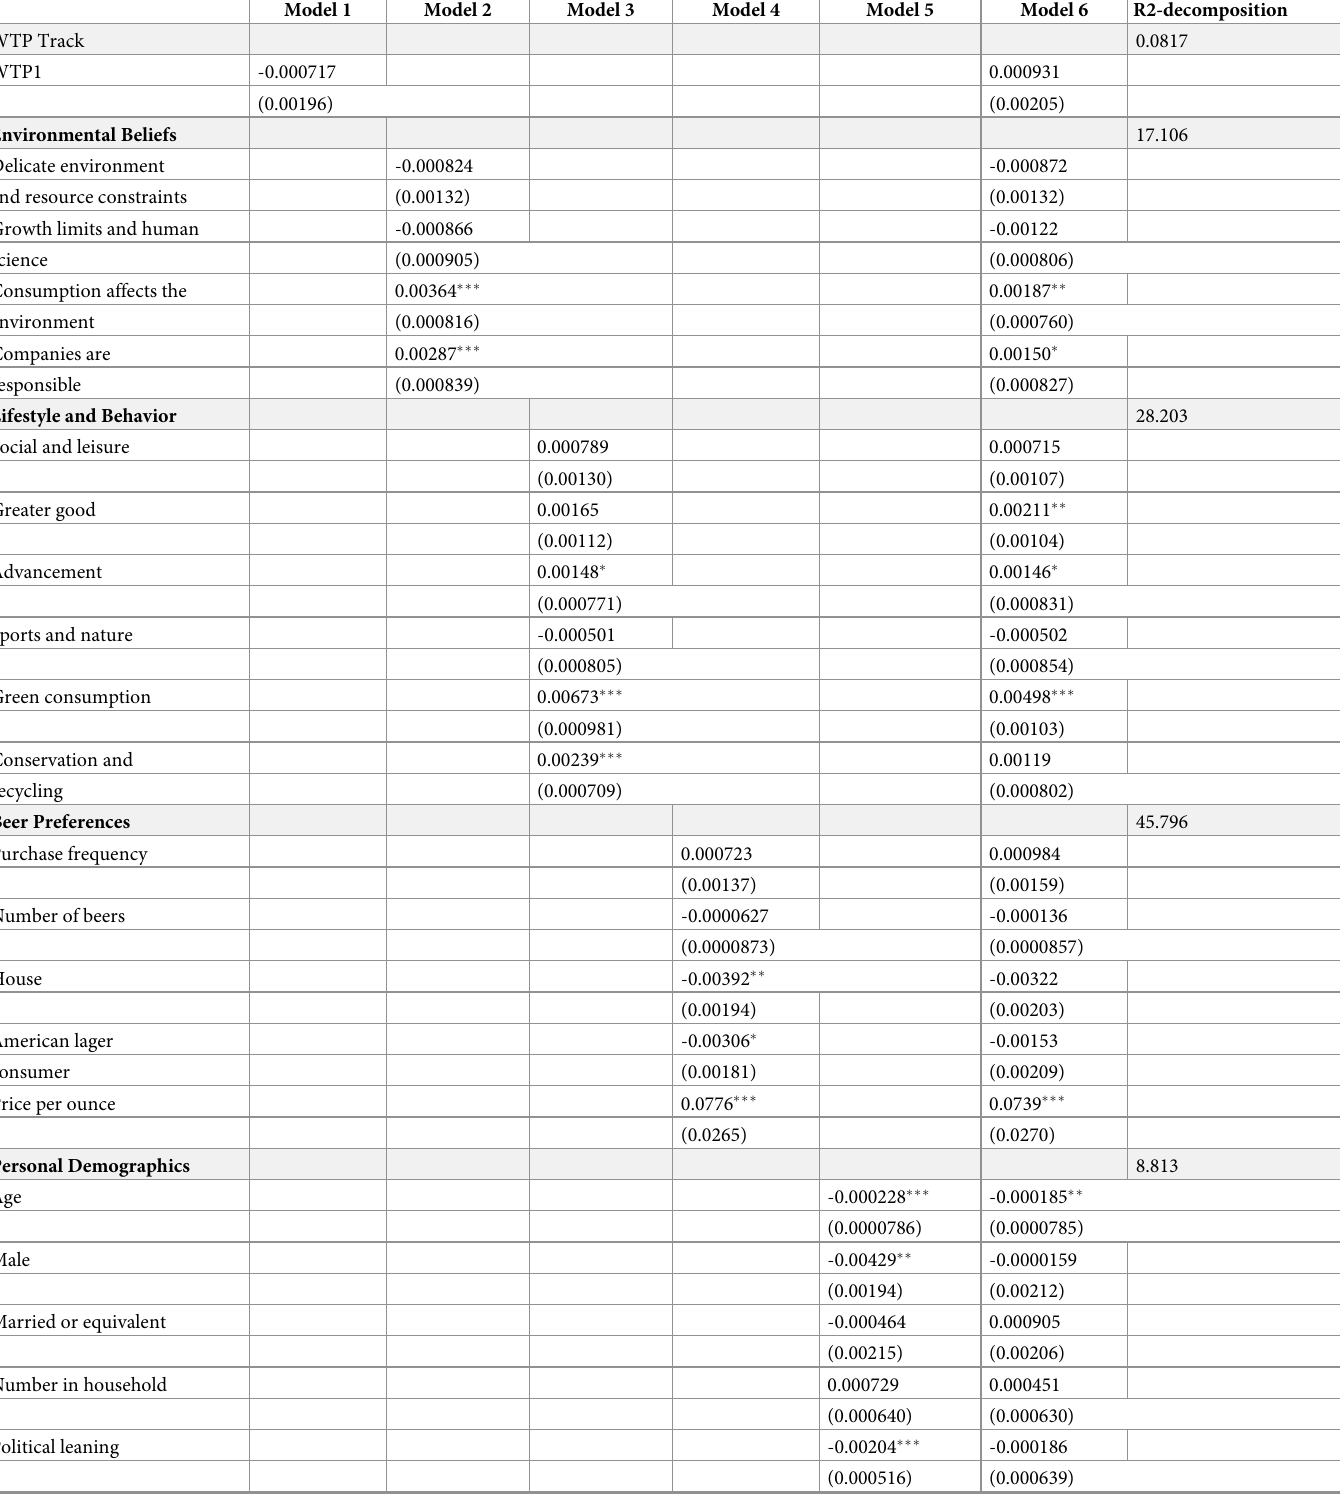
Table 6. Regression results with dependent variable WTP for sustainable beer (in